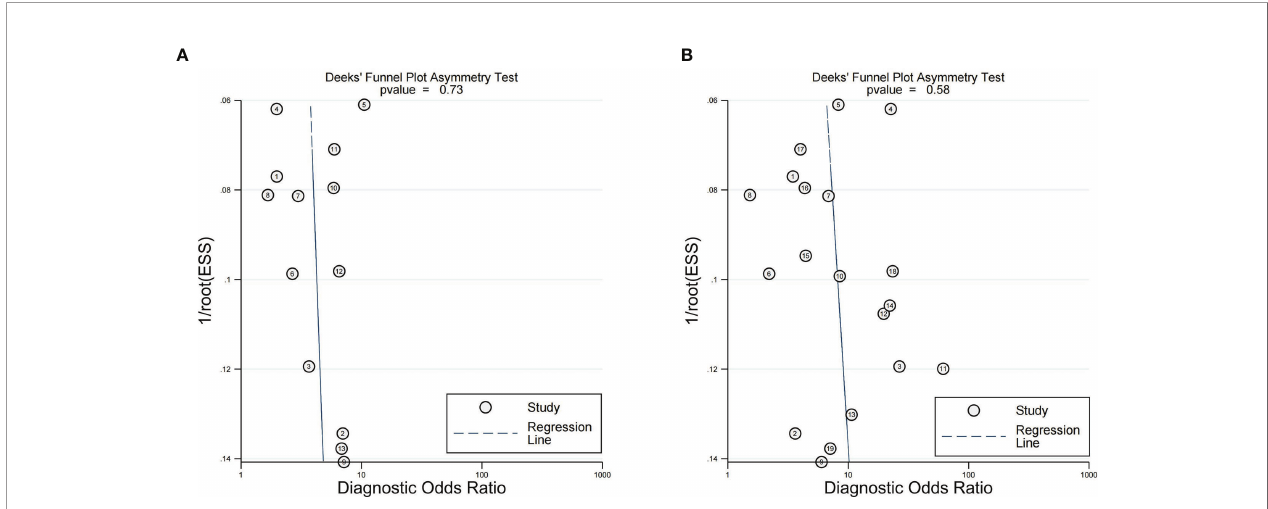
FIGURE 7 | Deeks' functional plots of peritumoral enhancement on the arterial phase (A) and peritumoral hypointension on the hepatobiliary phase (B)